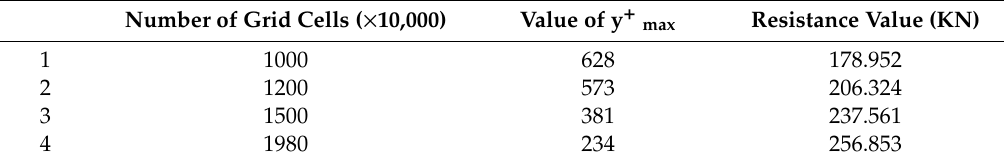
Table 5. Results of di ff erent grids.